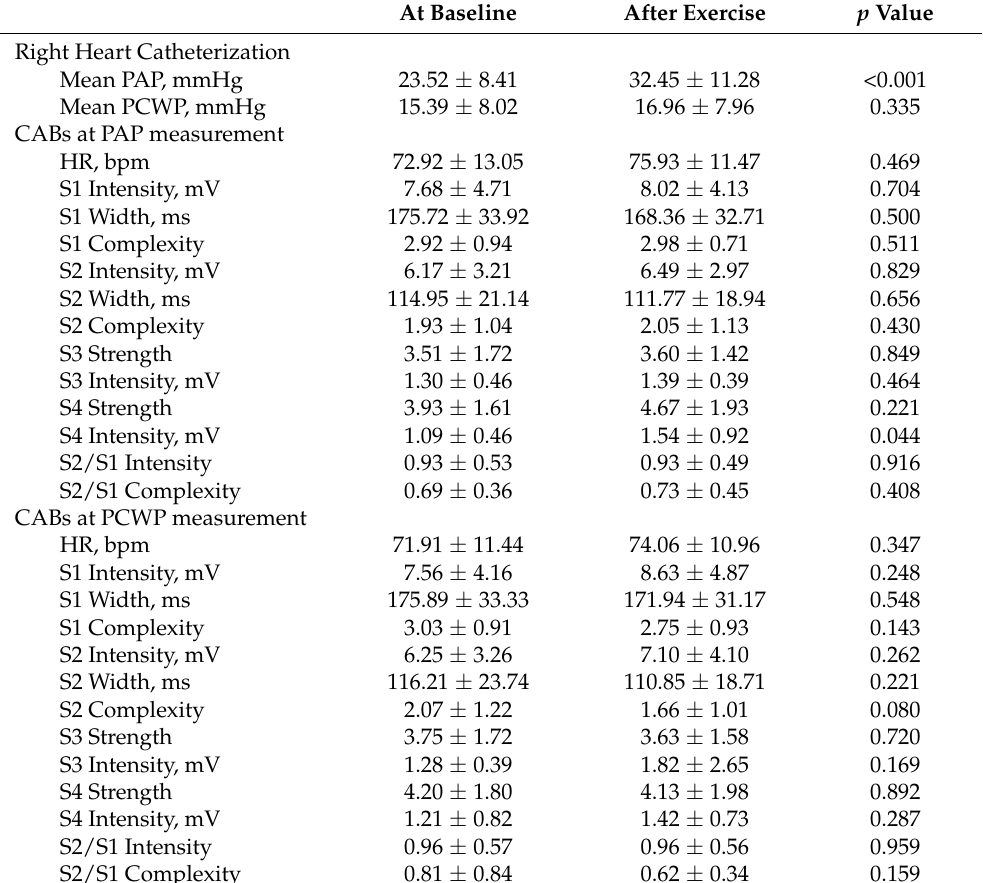
Table 2. Distribution of hemodynamic parameters by right heart catheterization and of CABs by